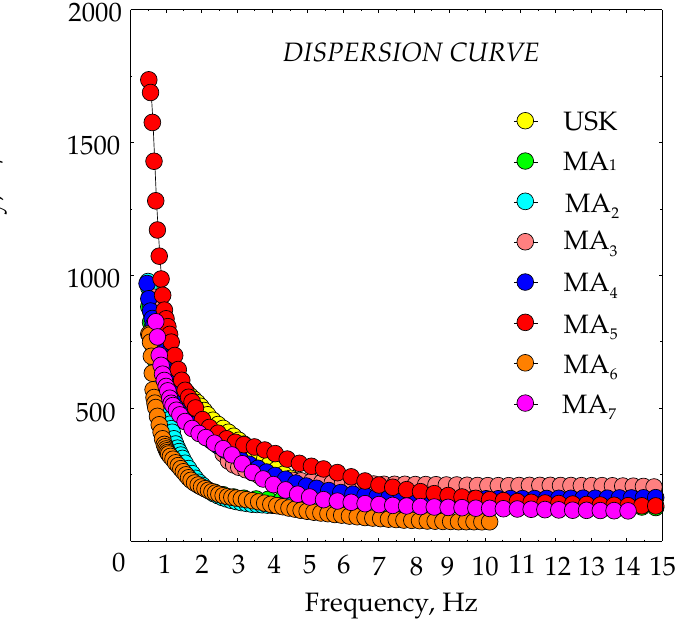
Figure 4. Aggregated dispersion curves from all site measurements.